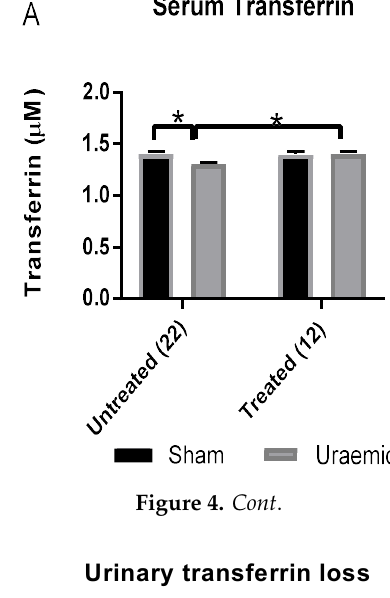
Figure 3. Iron analysis. ( A ) Haematocrit was measured to confirm anaemia; ( B ) Faecal Iron loss as a measure of iron malabsorption; ( C ) Urinary iron excretion was evaluated to study the cause of iron deficiency. Data are presented as mean ± SEM (* p < 0.05, ** p < 0.01).